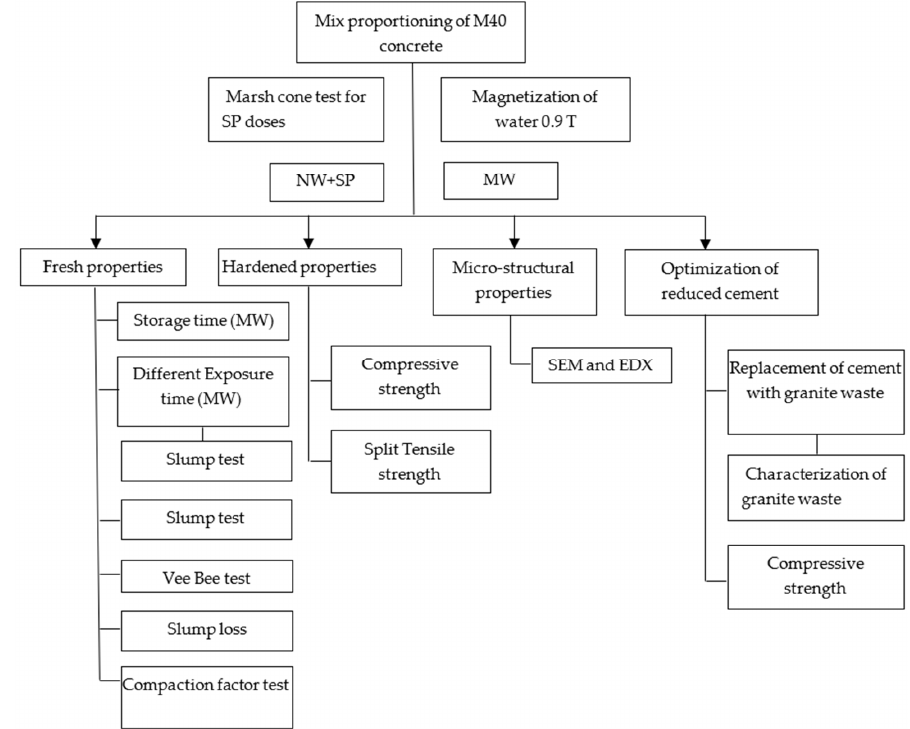
Figure 2. Study framework.